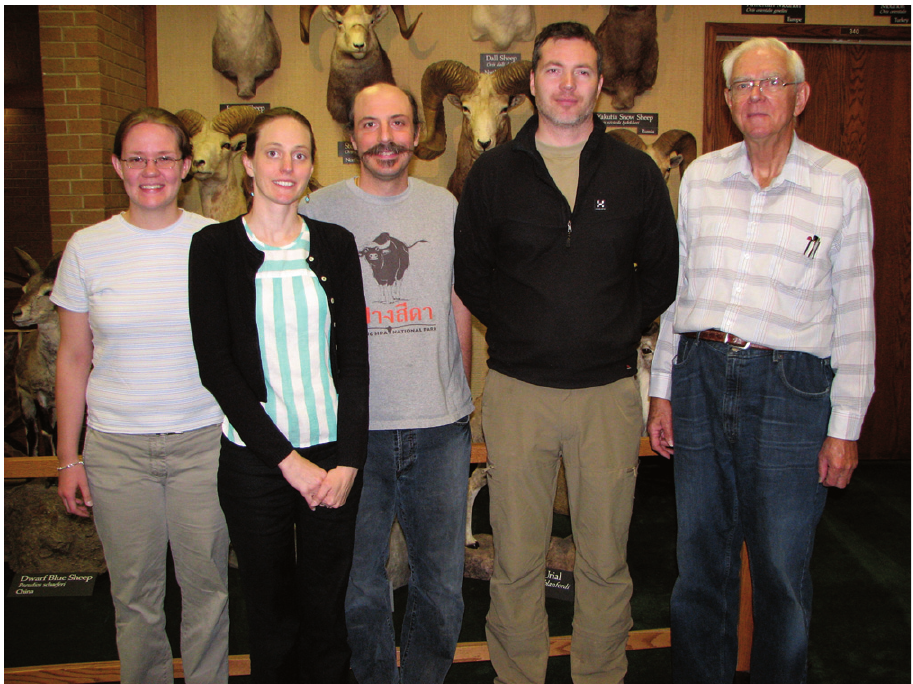
Figure 2. Th ree generations of scolytine systematists visiting Dr. Wood at BYU. From left to right: Sarah Smith, Stephanie Dole, Anthony Cognato, Bjarte Jordal and Stephen Wood,